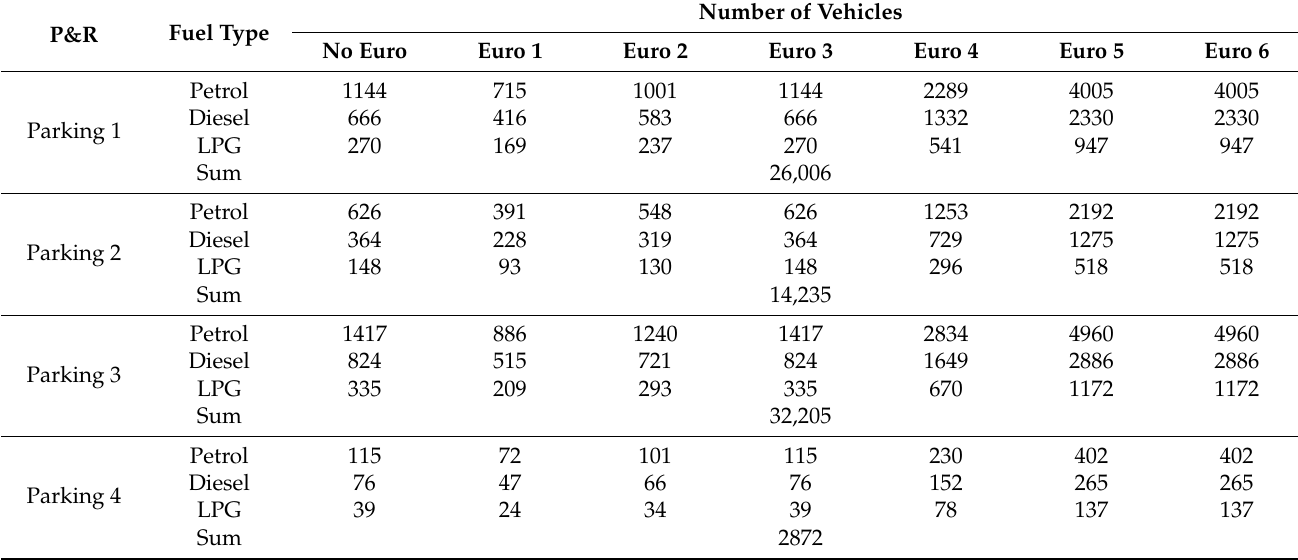
Figure 5. Data for passenger cars (%) according to the ( a ) EURO standard and ( b ) fuel used. The passenger car emissions for variant V0 were calculated considering the data on the number of cars in the individual P&R parking lots and the estimated average travel distances for buses used by the drivers of the cars left at P&R parking lots (Table 3). It was assumed that the distance travelled by drivers leaving cars at the parking lots is equal to half the distance travelled by the buses on each line from the stops located near the parking lots to their final stops. Data on the number of cars with respect to fuel type and emission class [21] adopted for the calculations are presented in Table 4. Table 4. Number of passenger cars fuelled with specific fuel types and emission standards used as inputs to